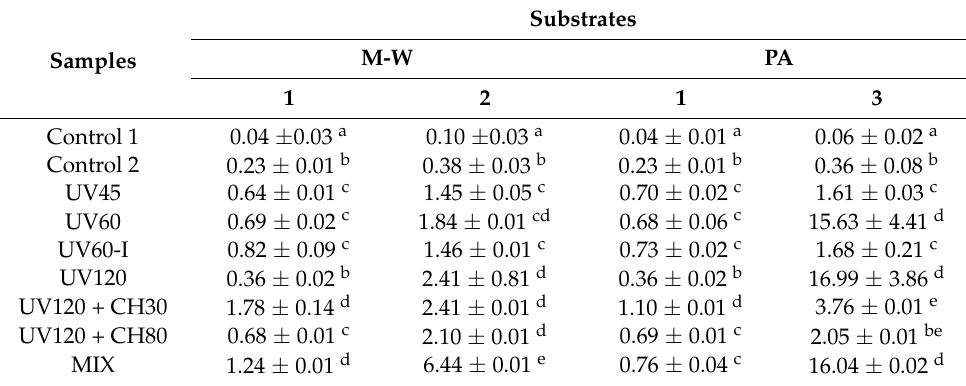
activity cellulase obtained using treated A. niger